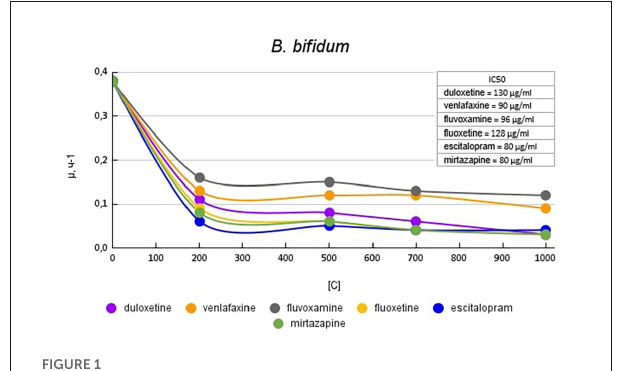
FIGURE1 Specific growth rates of B. bifidum in the presence of antidepressants.